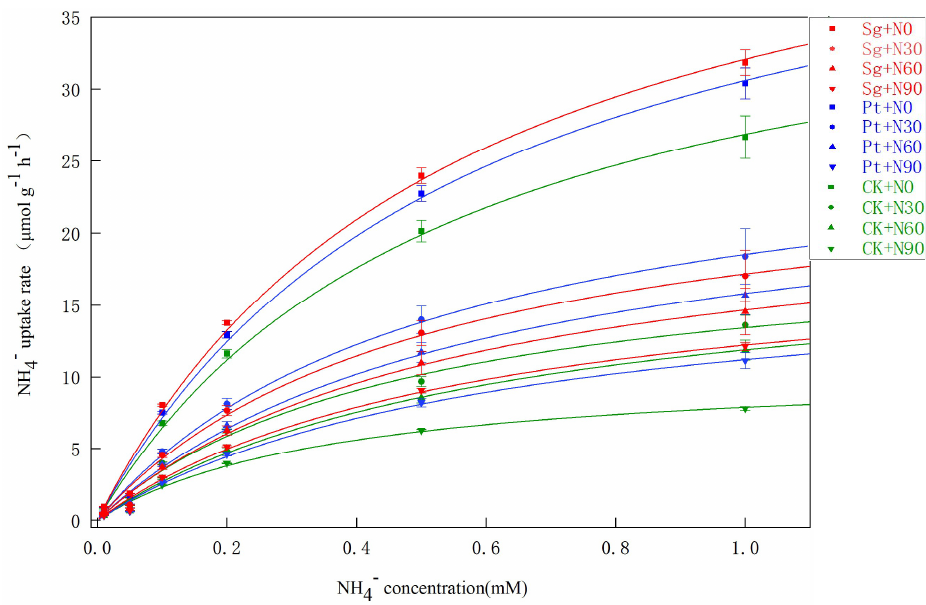
Figure 2. Uptake of NH 4+ by Pinus massoniana seedlings as a function of NH 4+ solution concentration. Note: Vertical bars illustrate standard errors of the means ( n = 3). CK: control. Sg: Suillus grevillei .